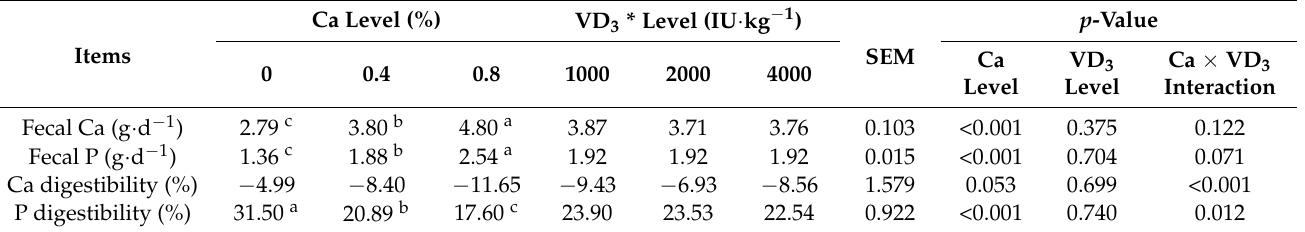
Table 5. The outcome of Ca and VD 3 diet supplementation on Ca and P digestibility in maturing and furring blue foxes.